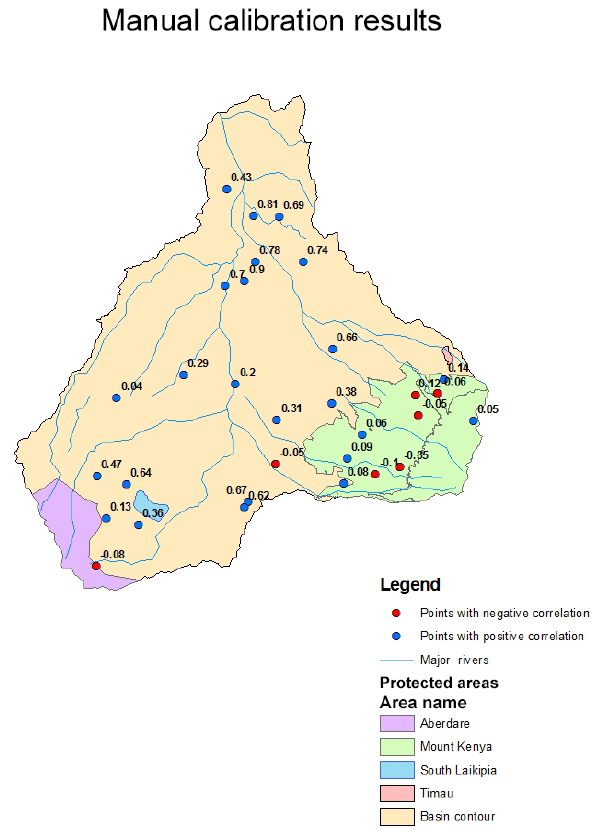
Figure 2. Location of the points where the manual calibration was carried out. The value of the Pearson correlation coefficient between the satellite NDVI and the simulated LAI appears together with the point used for the manual calibration of the